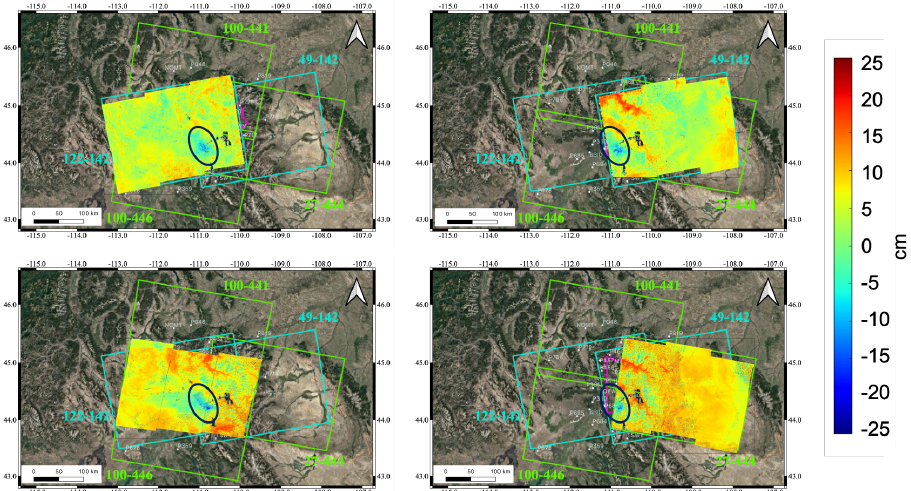
Figure 10. Cumulative displacements between May 2017 and August 2018 over the Yellowstone area (see details about each frame in Table 1) obtained from four different acquisition frames of Sentinel-1 data. Red areas show uplift, which is apparently coinciding with steep valleys. Blue areas represent subsidence; black circles identify consistent subsidence on all four images.